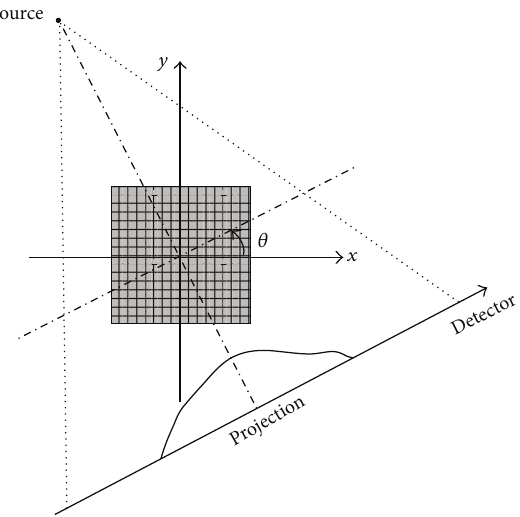
Figure 1: Fan-beam CT geometry